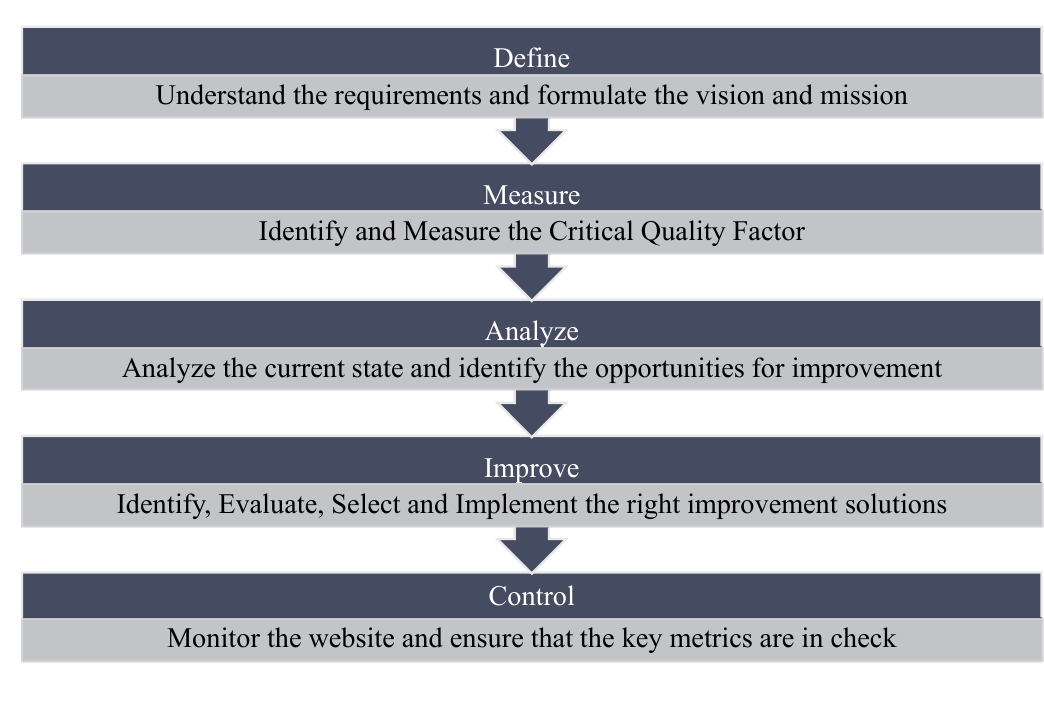
Fig. 2. DMAIC Methodology